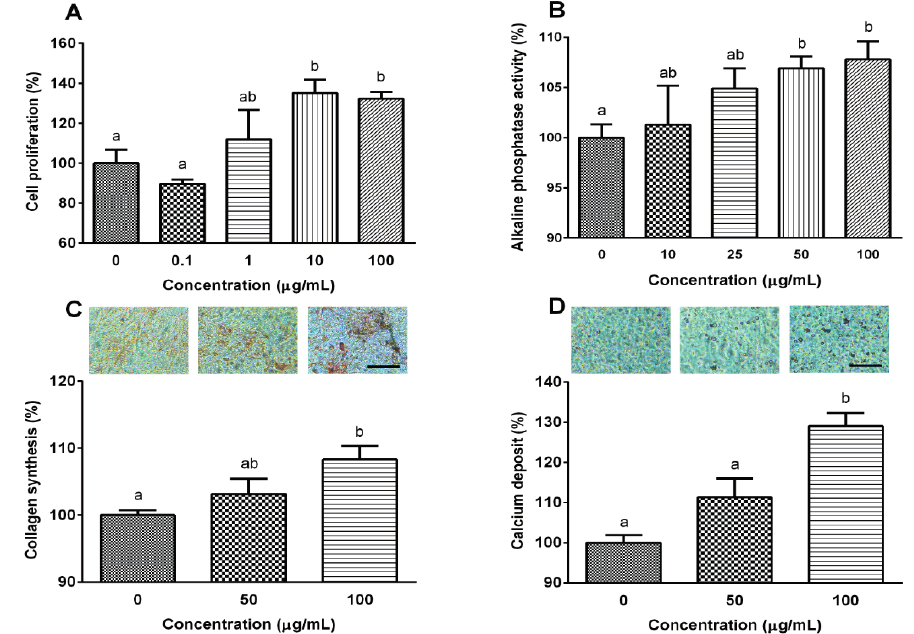
Figure 1. ( A ) Effects of YPEP on cell proliferation; ( B ) alkaline phosphatase activity; ( C ) collagen synthesis, and ( D ) calcium deposit. Data are expressed as a percentage of the control value, means ± SD of the three cultures. Values not sharing a common alphabet as superscripts are significantly different from each other at the level of p < 0.05.